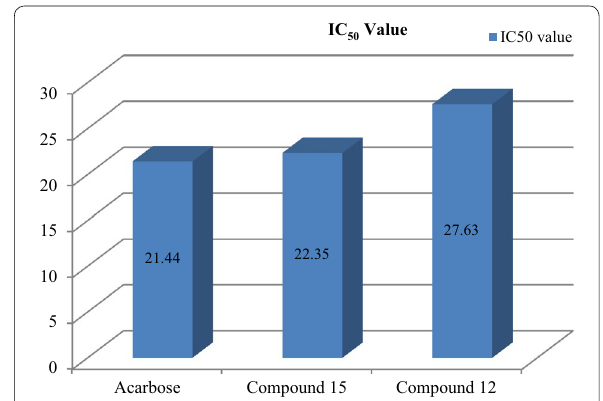
heat applied, after that the reaction mixture was stirred and refluxed for 8–10 h at 100–110 °C. The product was cooled, filtered, washed and dried at room temperature followed by recrystallization with suitable solvent [9].